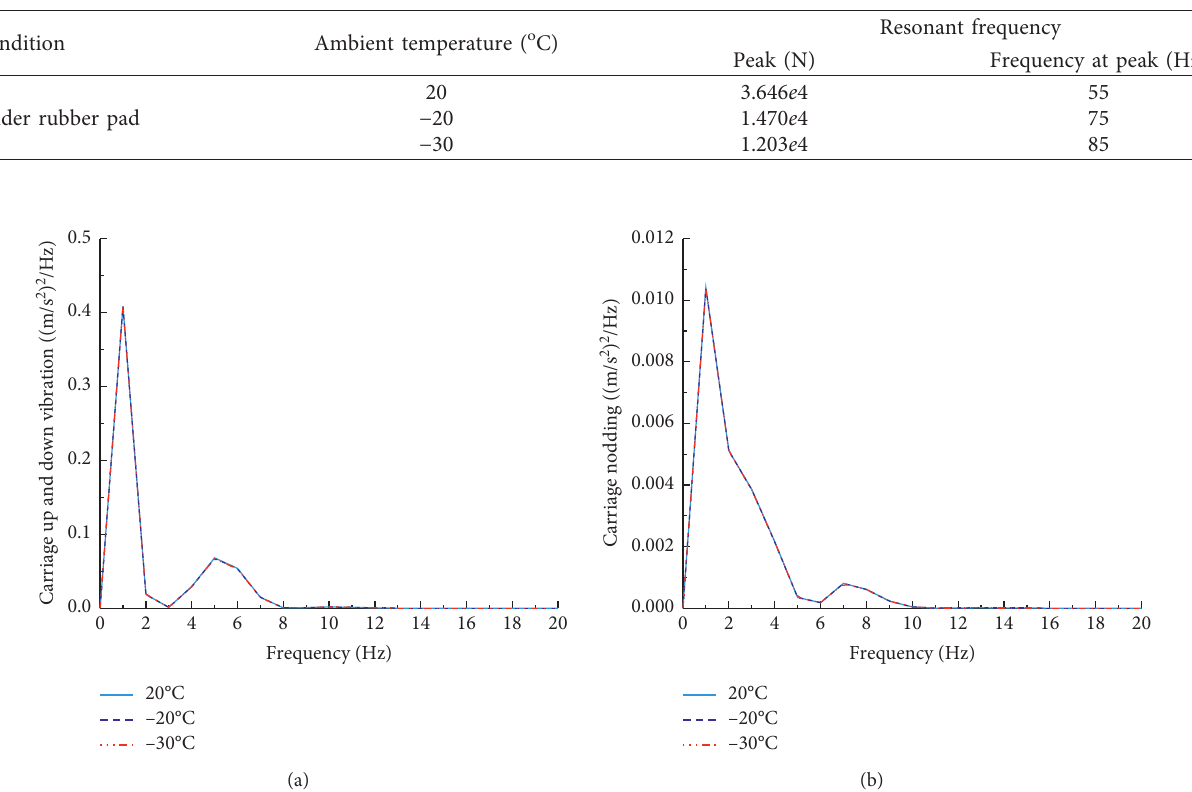
Figure 16: Wheel-rail force amplitude. Table 5: Wheel-rail peak force and peak frequency.